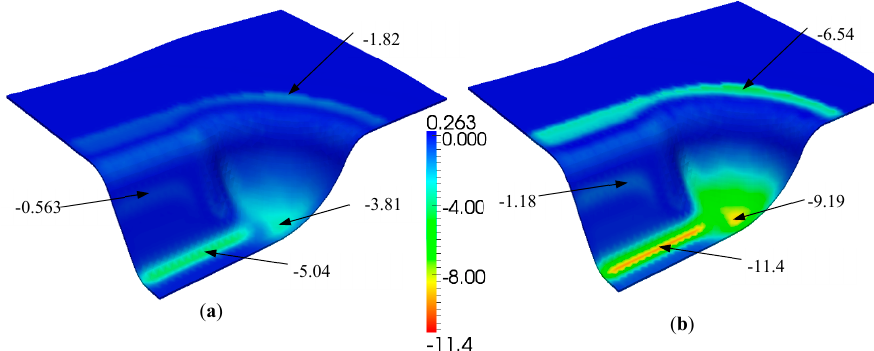
Figure 12. Distribution of transverse stress σ 33 (middle face) during the consolidation process: ( a ) σ 33 (MPa) for ∆ u = 0.2 mm; ( b ) σ 33 (MPa) for ∆ u = 0.5 mm.